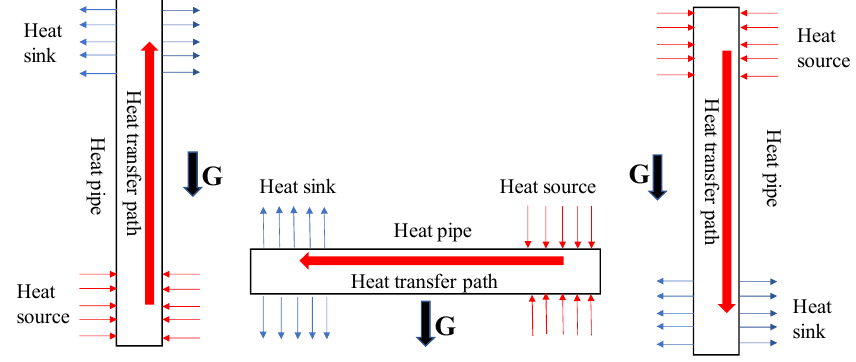
ff erent positions of heat pipes when Figure 2. Different positions of heat pipes when working. Figure 2. Di